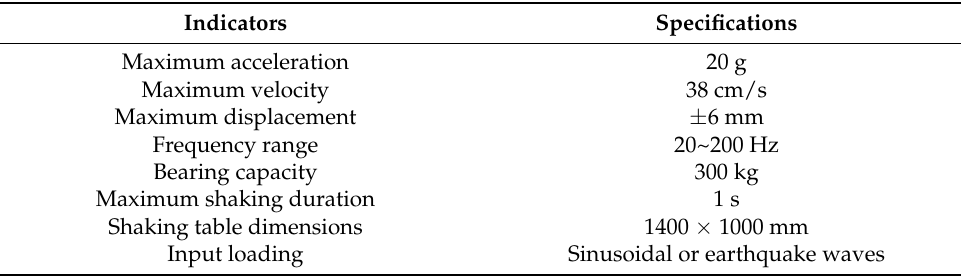
Figure 2. Test facilities:( a ) electro-hydraulic shaking table; ( b ) laminar shear model box. Table 1. Specifications of TLJ-150 centrifuge shaking table. Indicators